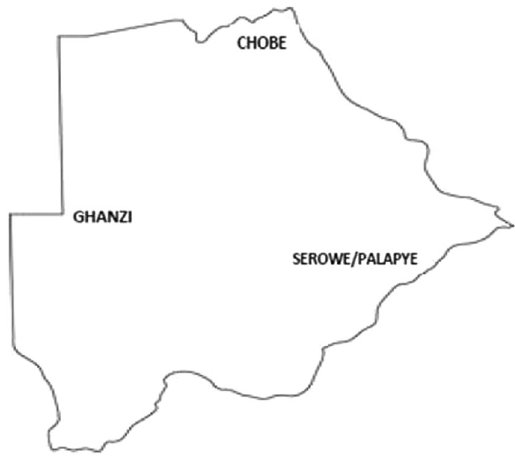
Figure 1. Map of